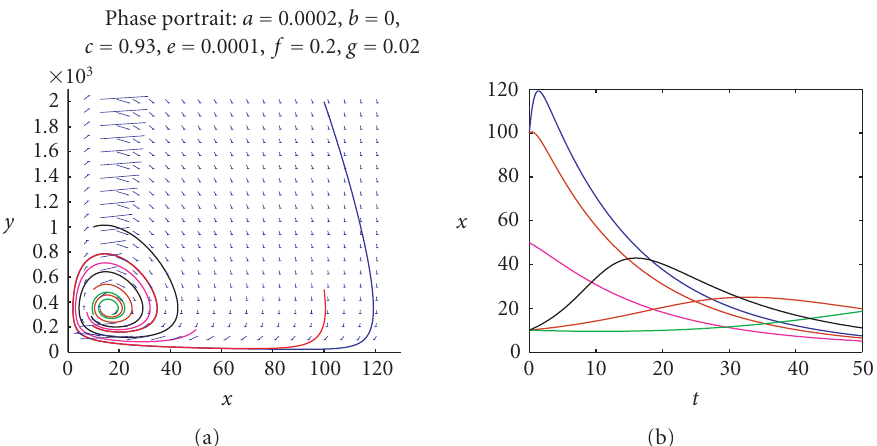
Figure 3.8. The presence of nonviolent intervention causes the dynamical system to exhibit a fixed point. Unlike the explosion in the terrorist population that occurs when b = e = 0 and c + f > 1, with c < 1, the terrorist population in the presence of nonviolent intervention is bounded and the dynamical trajectories here are spirals in phase space. The fixed point is at x 0 ≈ 16, y 0 = 350. The parameters are the same as those used in Figure 3.2 except that e >